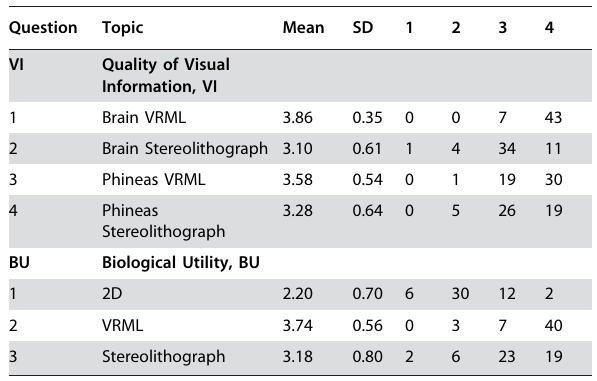
Table S1 Gillespie Rating Survey